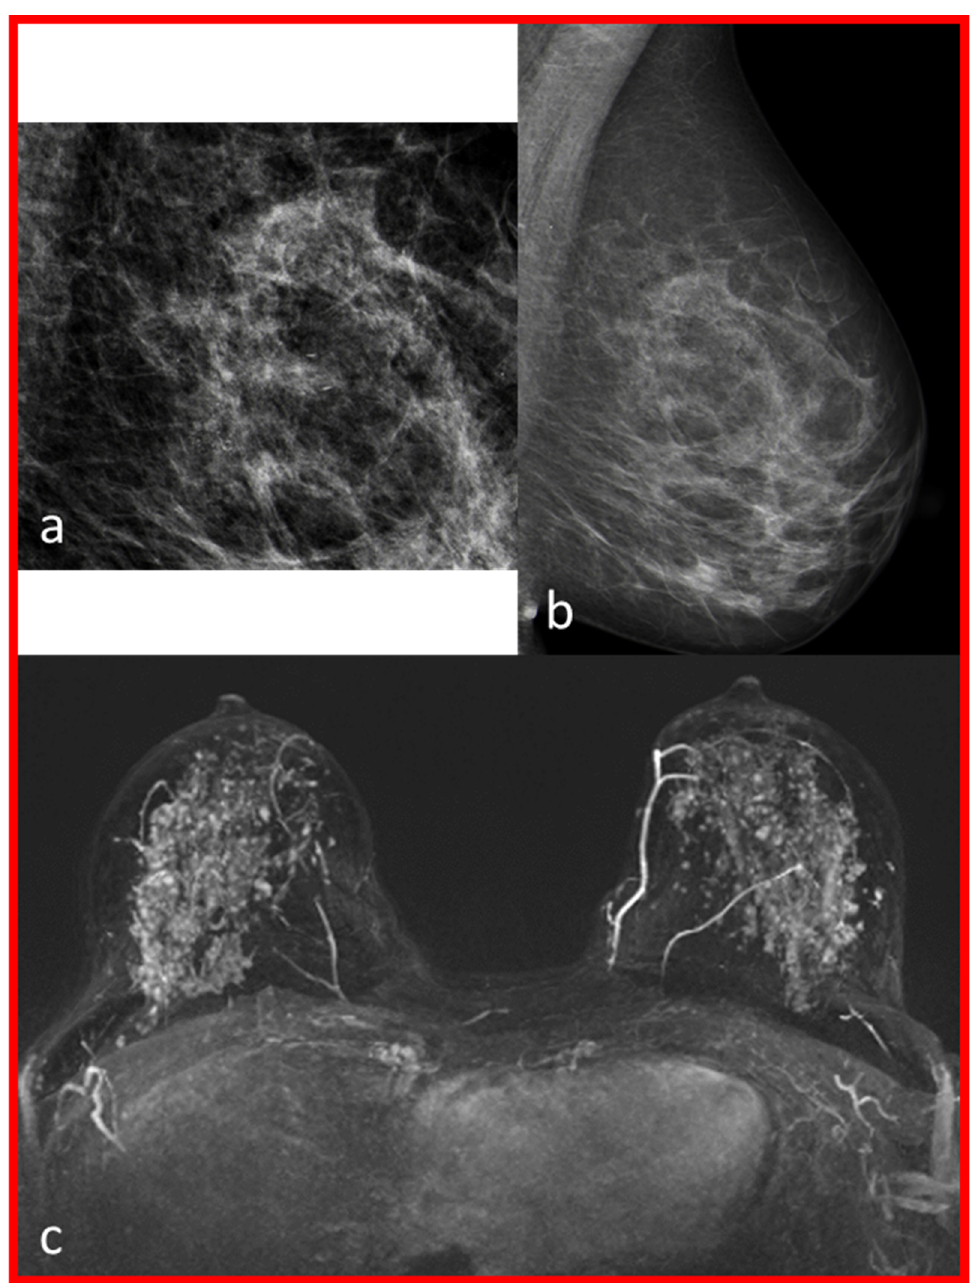
Figure 2. The mammography and breast magnetic resonance images (MRI) of patient number two of Table 3 are shown. Amorphous, regional MCs of the left breast on the left in MLO (mediolateral- oblique)—projection (images ( a , b )). Early post-contrast phase MIP (maximum intensity projection): no suspicious lesion identifiable on both sides, possibly due to the strong BPE (background paren- chymal enhancement) assessed as pronounced (image ( c )).